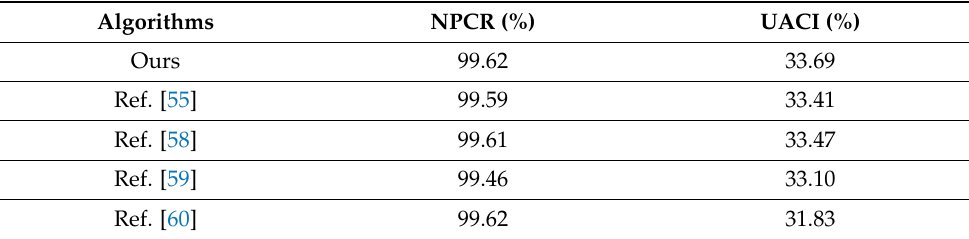
Table 6. Performance of NPCR and